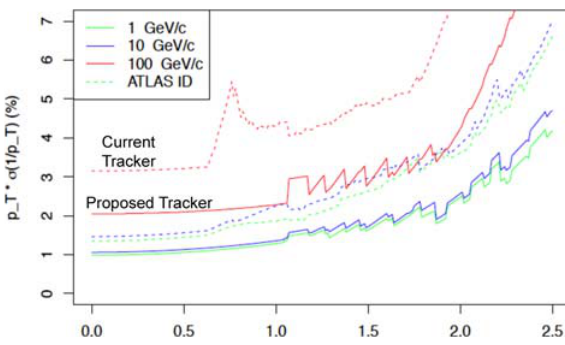
Figure 8. Predicted muon momentum resolution of the new tracker (solid lines) compared with observations from current tracker (dotted lines) for three di ff erent momentum